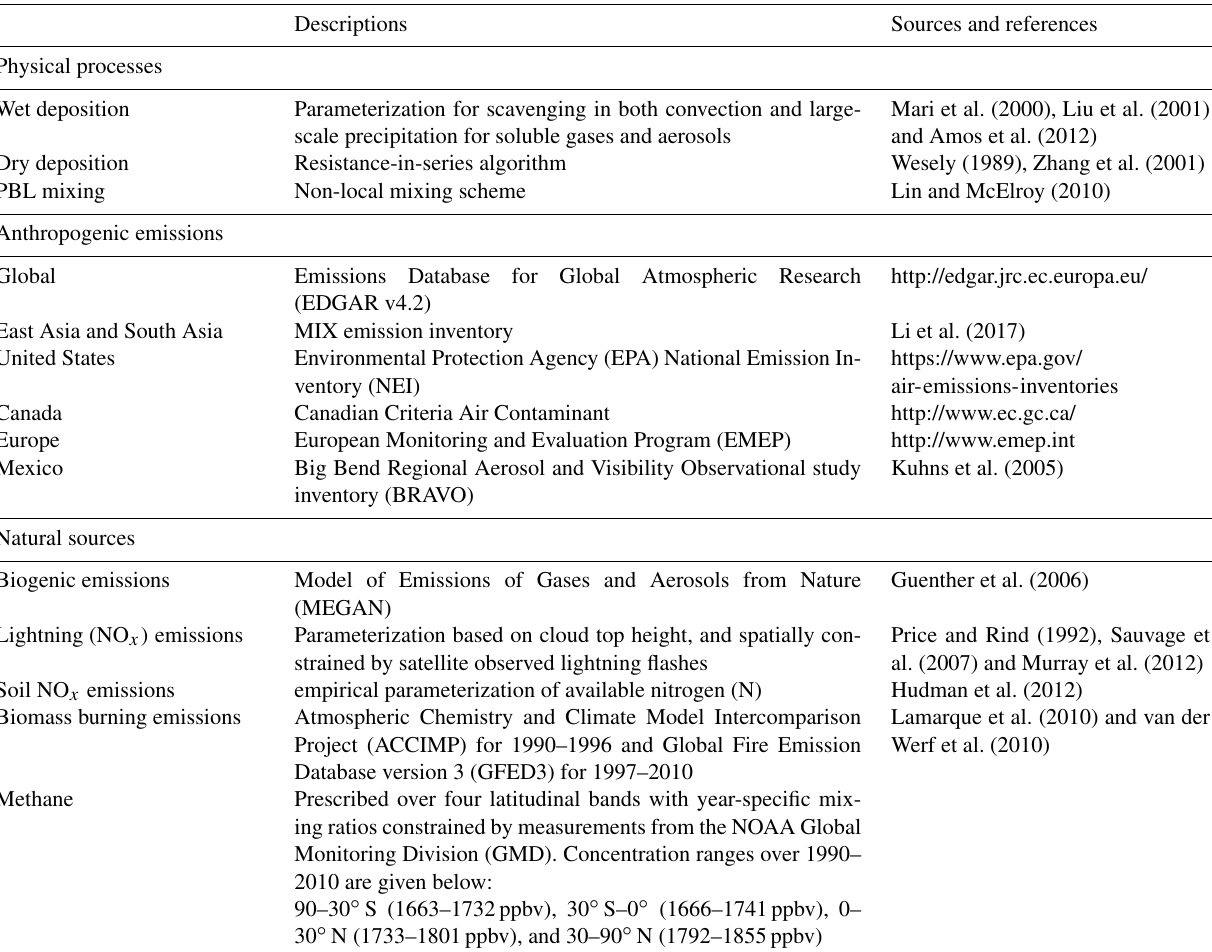
Table 1. A summary of physical processes, anthropogenic and natural emissions used in